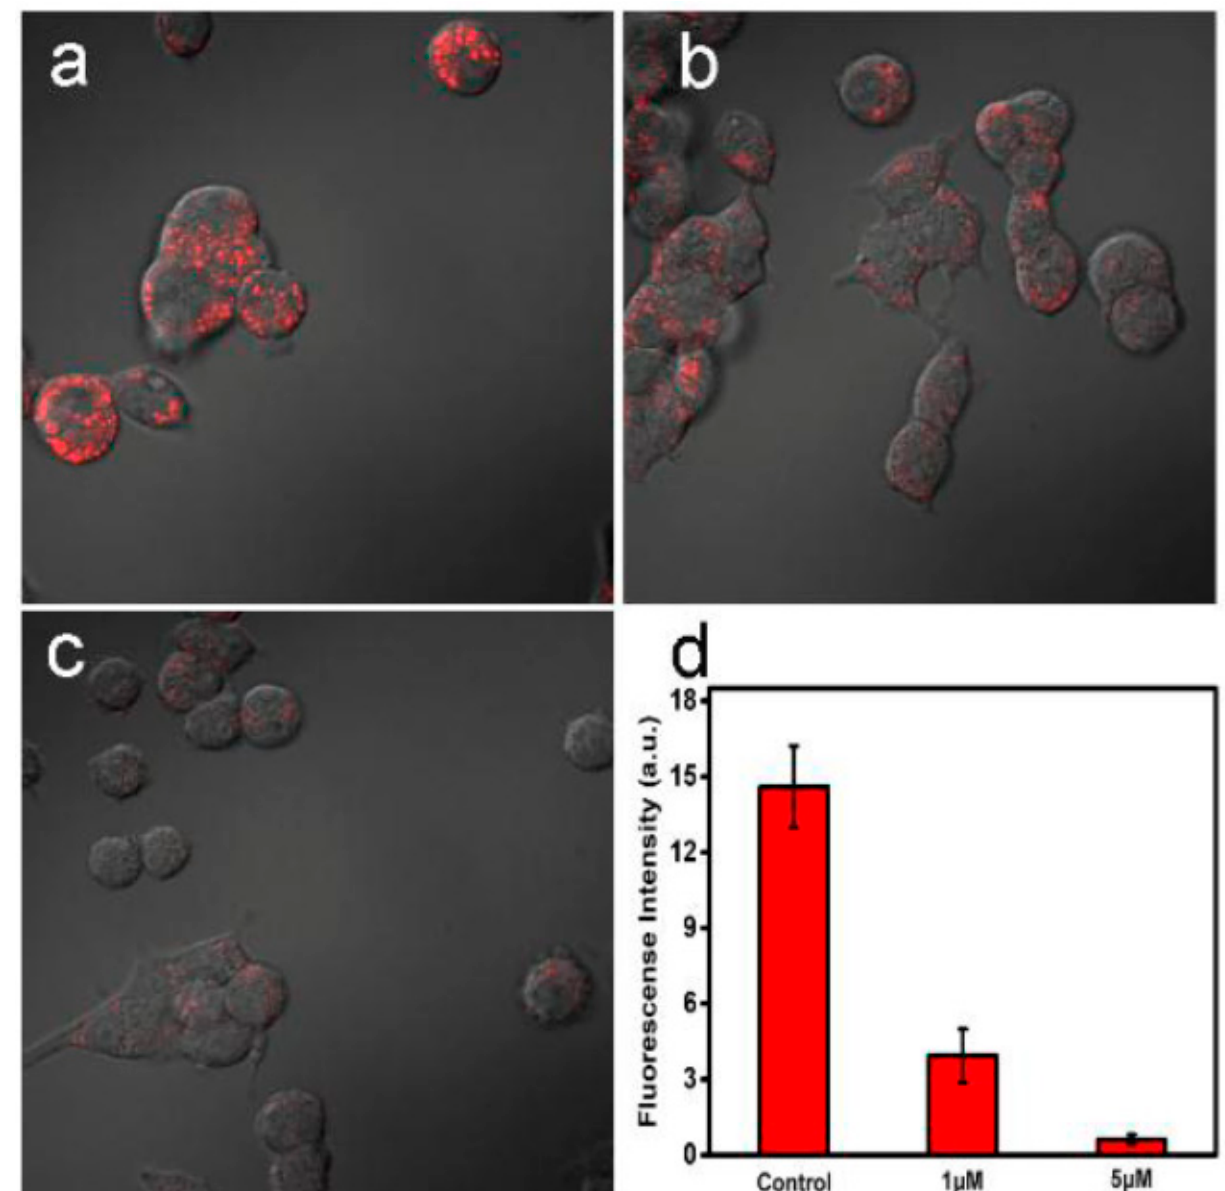
Figure 8. FL images of living PC12 cells stained with 5.0 µ M S,N-C-dots: ( a ) in the absence of Fe 3+ (control sample), ( b ) in the presence of 1.0 µ M Fe 3+ , ( c ) in the presence of 5.0 µ M Fe 3+ . ( d ) The PL intensity of samples described in ( a – c ). Reprinted (adapted) with permission from [74]. Copyright 2021 Elsevier.